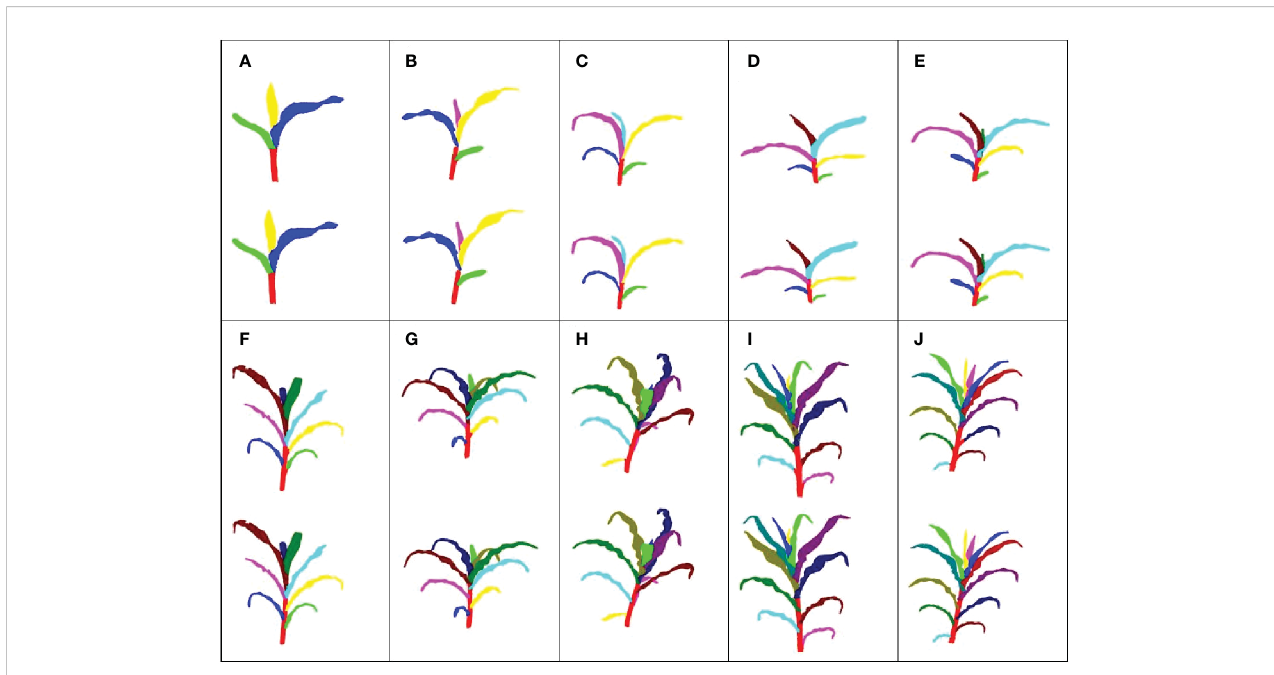
FIGURE 5 Visualization results of stem and leaf segmentation. The top image in each fi gure represents the result of our method, while the bottom image represents the ground truth. (A) Three leaves; (B) Four leaves; (C) Five leaves; (D) Six leaves; (E) Seven leaves; (F) Eight leaves; (G) Nine leaves; (H) Ten leaves; (I) Eleven leaves; (J) Twelve leaves.